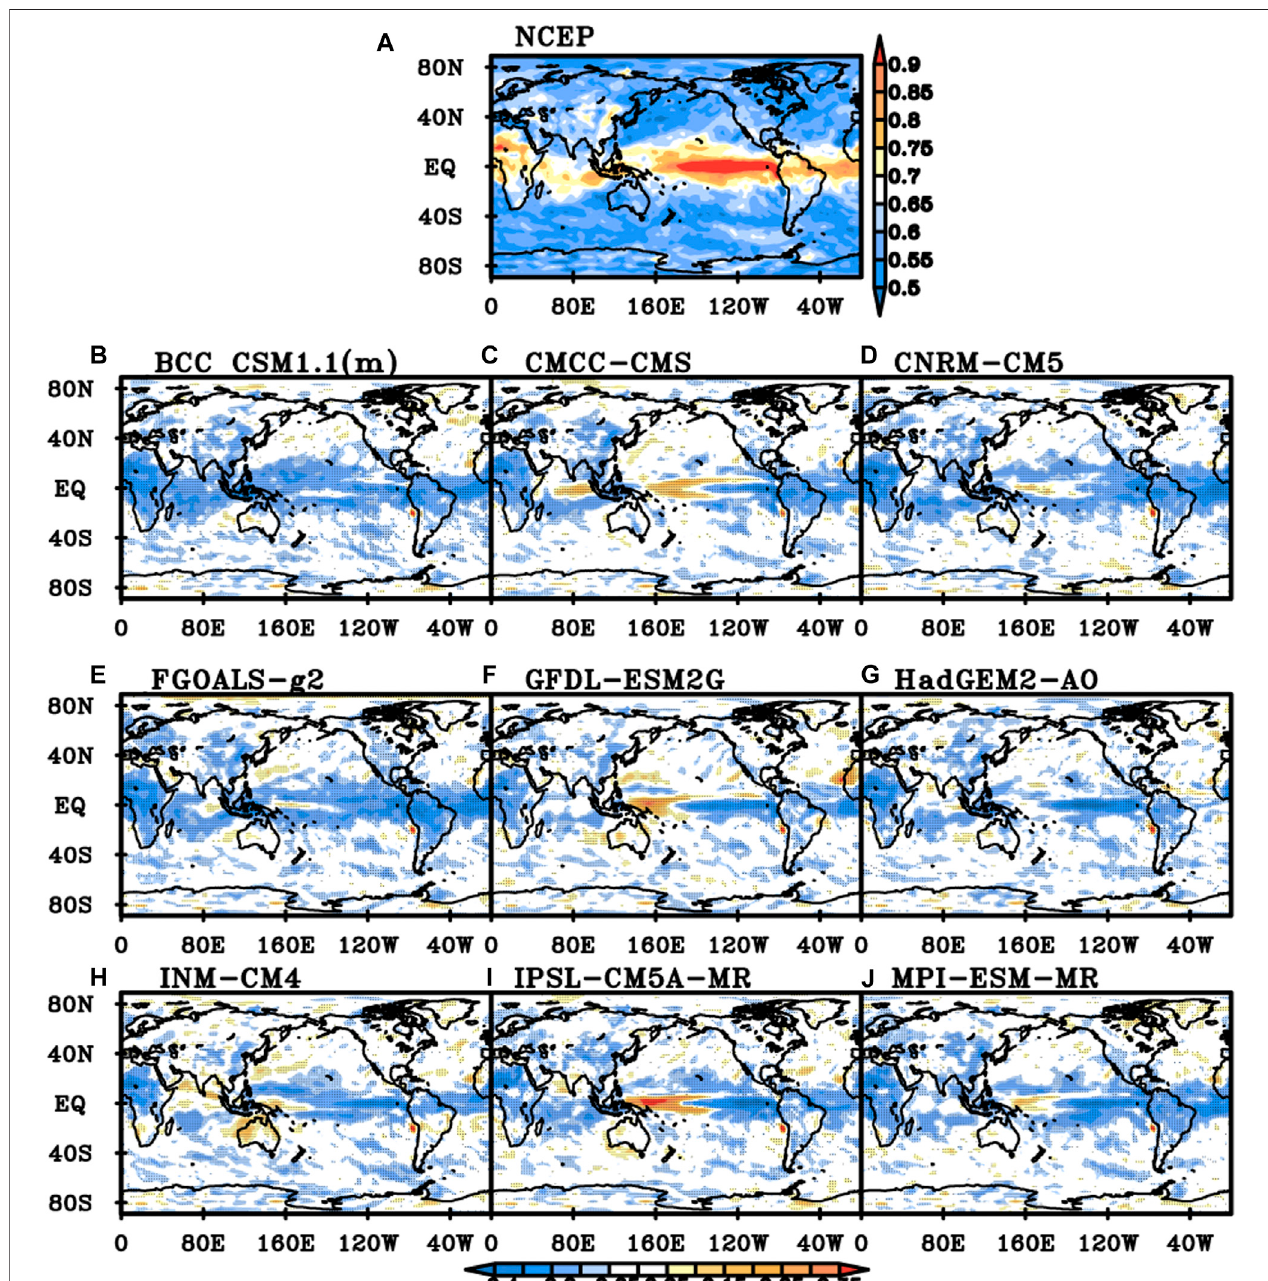
FIGURE 7 | Scaling exponents of NCEP daily precipitation and differences between NCEP and nine CMIP5 models for annual average. (A) NCEP daily precipitation, (B) BCC_CSM1.1(m), (C) CMCC-CMS, (D) CNRM-CM5, (E) FGOALS-g2, (F) GFDL-ESM2G, (G) HadGEM2-AO, (H) INM-CM4, (I) IPSL-CM5A-MR, (J) MPI-ESM-MR (Black dot represents the difference is signi fi cant at a signi fi cance level of 0.05).